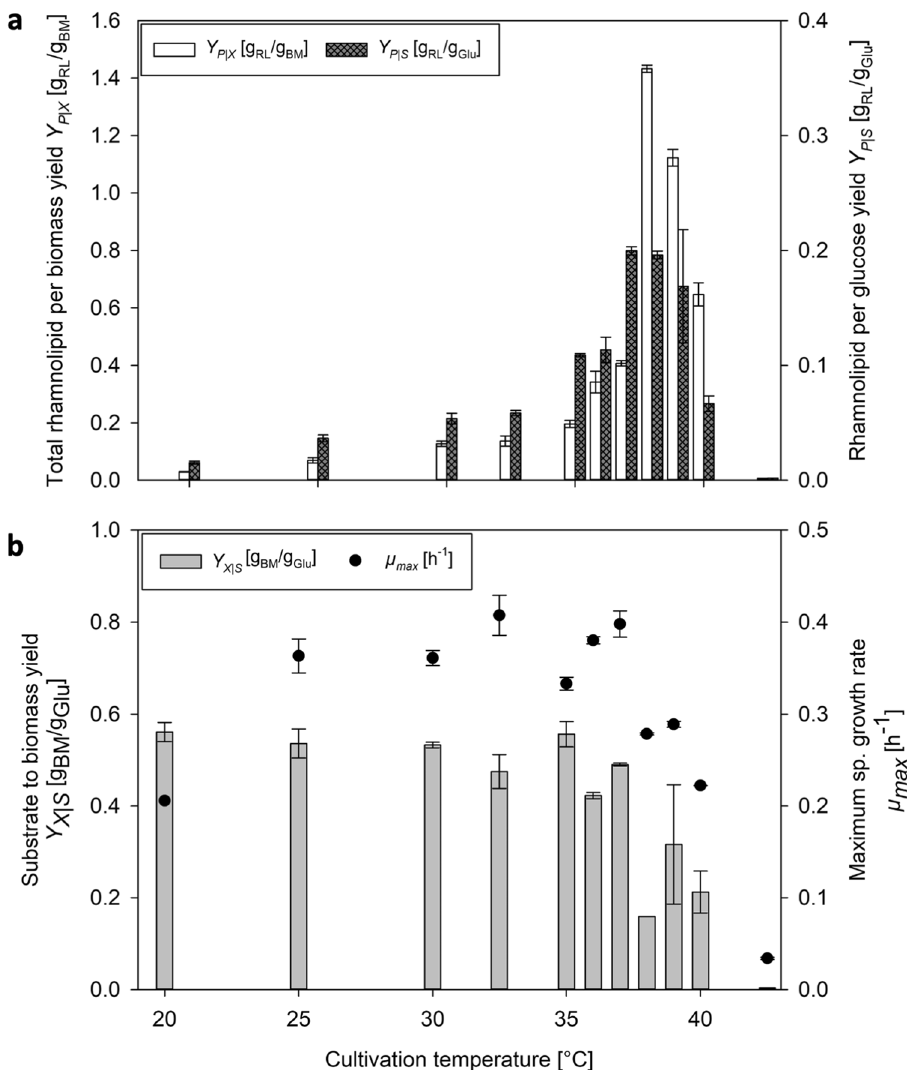
Figure 4. Effect of temperature on ( a ) rhamnolipid-per-glucose yields ( Y P|S ; dark grey bars) and total rhamnolipid-per-biomass yields ( Y P|X ; white bars) and on ( b ) biomass-per-glucose yields ( Y X|S ; grey bars) and maximum specific growth rates ( µ max ; circles) for Pseudomonas putida KT2440 pSynPro8oT_4U_